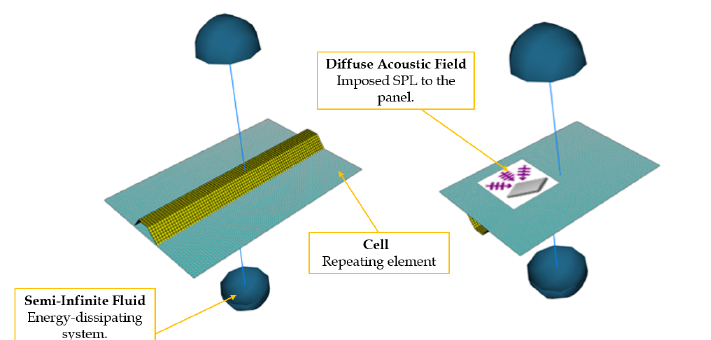
Figure 6. VAOne WFEM